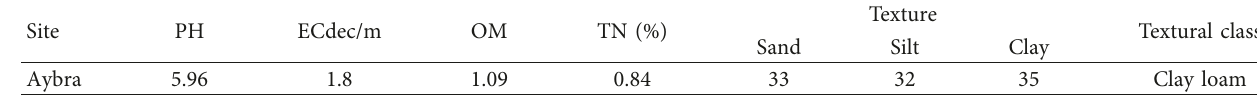
Table 1: Soil physicochemical property.